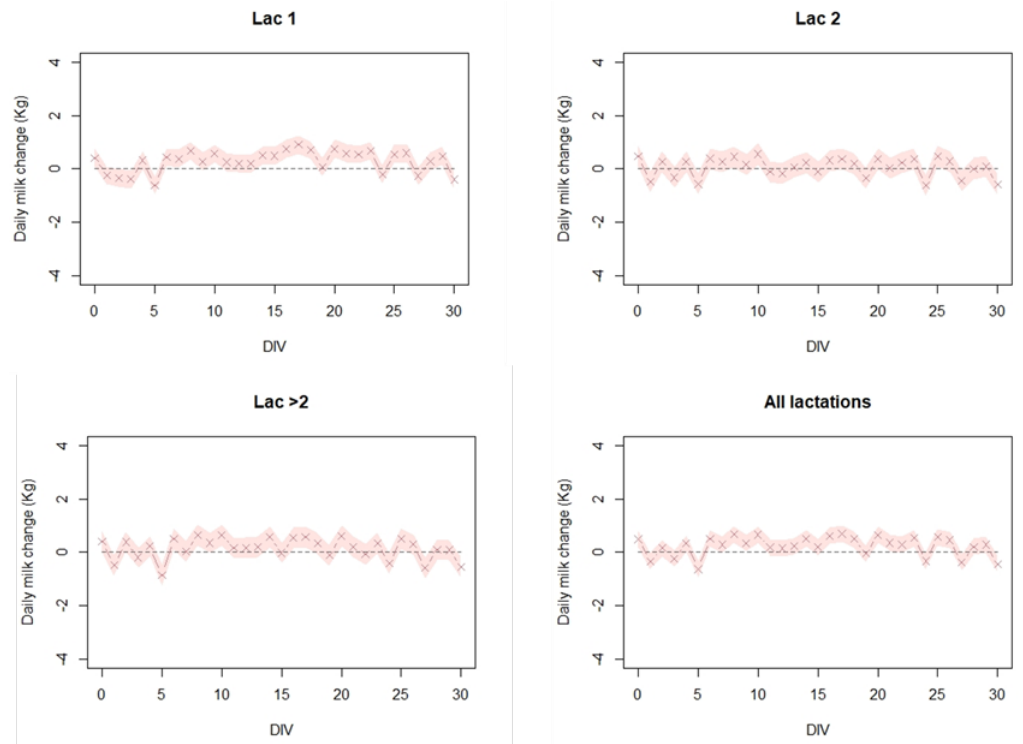
Figure 3. The estimated daily milk change (Kg) per cow in 73 dairy cattle farms in Israel, during a 30-day period after vaccination. Linear mixed effects model was fitted to the milk production gaps (MPG) for each cow with distance from vaccination day (DIV) as a fixed variable and the farm as a random variable. This was performed separately for lactation group 1 (Lac 1), lactation group 2 (Lac 2), lactation group > 2 (Lac > 2), and all lactation groups combined (All lactations). For specific details on the model, see text.